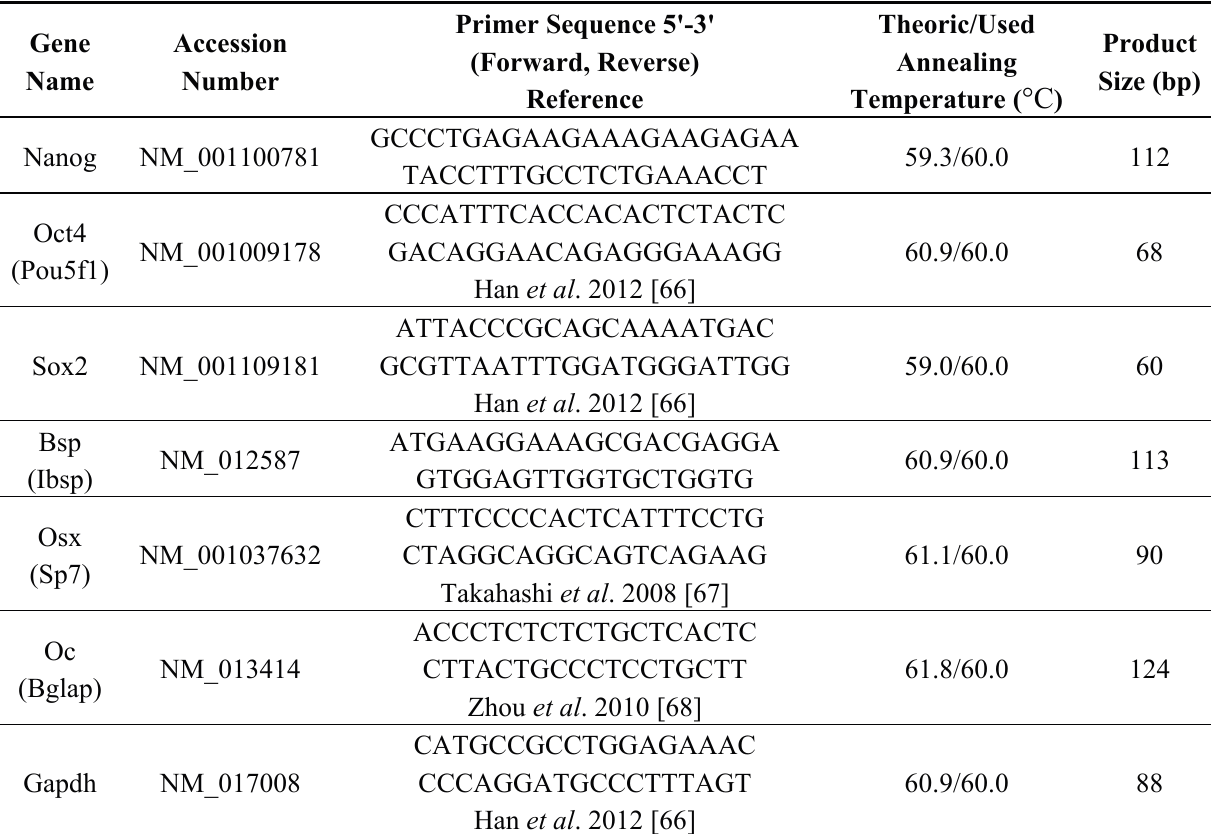
Table 2. Primer sequences for RT-qPCR with the expected product